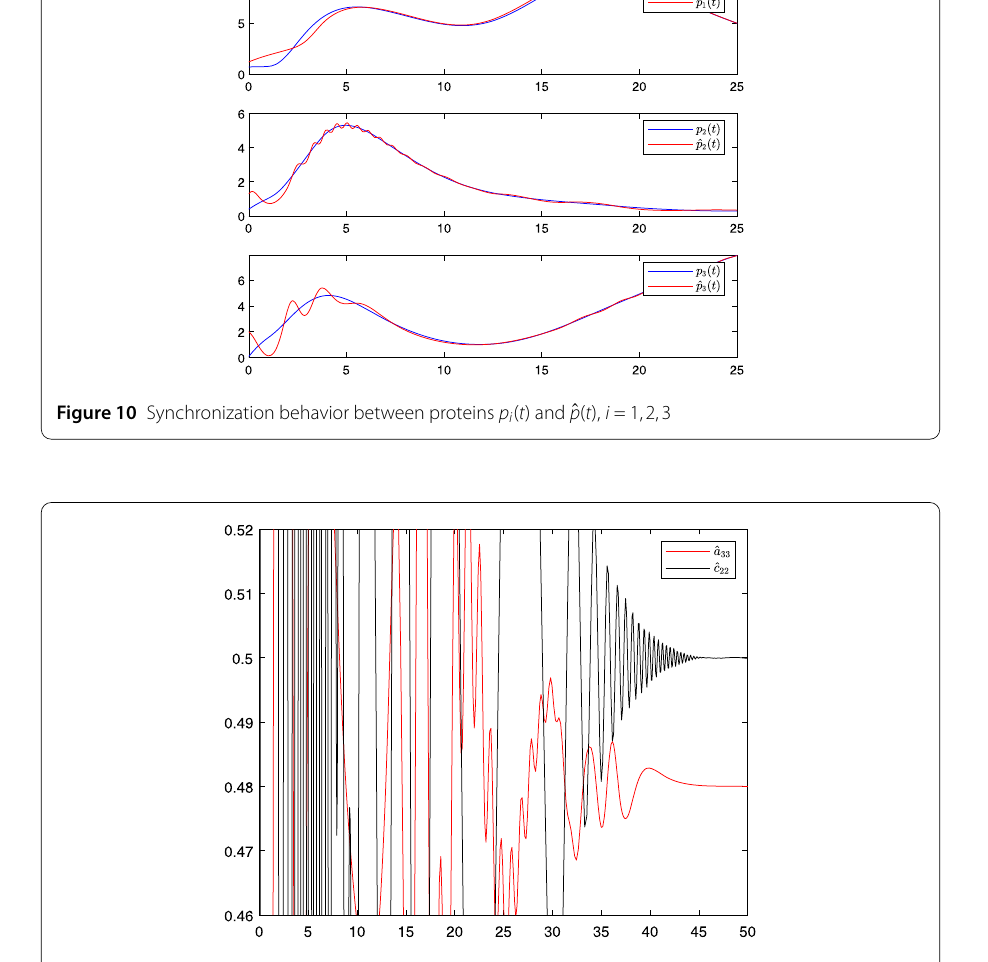
Figure 11 The temporal evolution of the estimated parameters ˆ a 33 and ˆ c 33